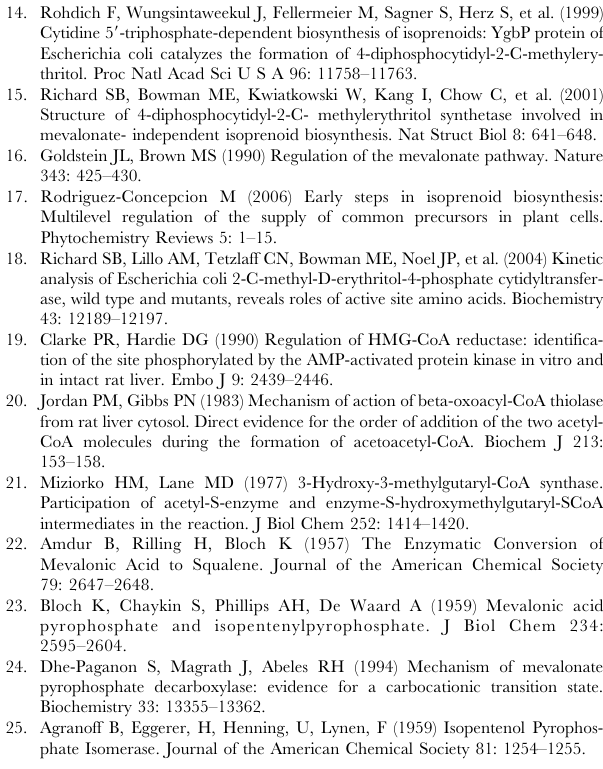
Figure S1 Molecular weight determination by size- exclusion chromatography. Protein standards ( & ) were used to calibrate the column. Linear regression fitting (R 2 is indicated) generated the standard curve, which was used to determine the molecular weight of wildtype MEP cytidylyltransferase (IspD) and the two mutants (T141D and T141E). Figure S2 ProQRes evaluation of the F. tularensis MEP cytidylyltransferase structural model generated by I- TASSER. ProQRes uses atom-atom contacts, residue-residue contacts, solvent accessibility, and secondary structure information